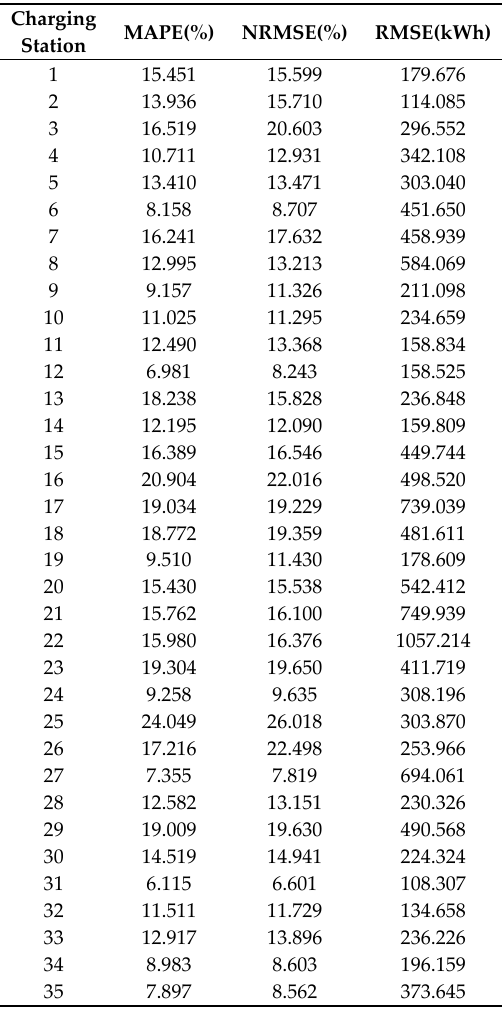
Table 2. Results from charging stations on Jeju island applying the EV charging power consumption regression